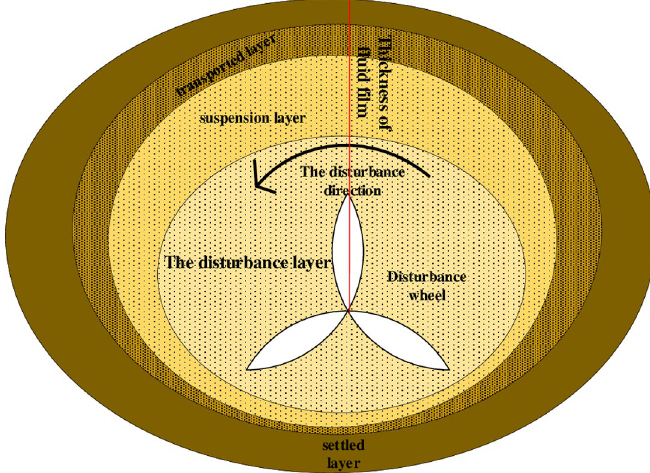
Fig 2. Model diagram of slurry flow film structure under physical